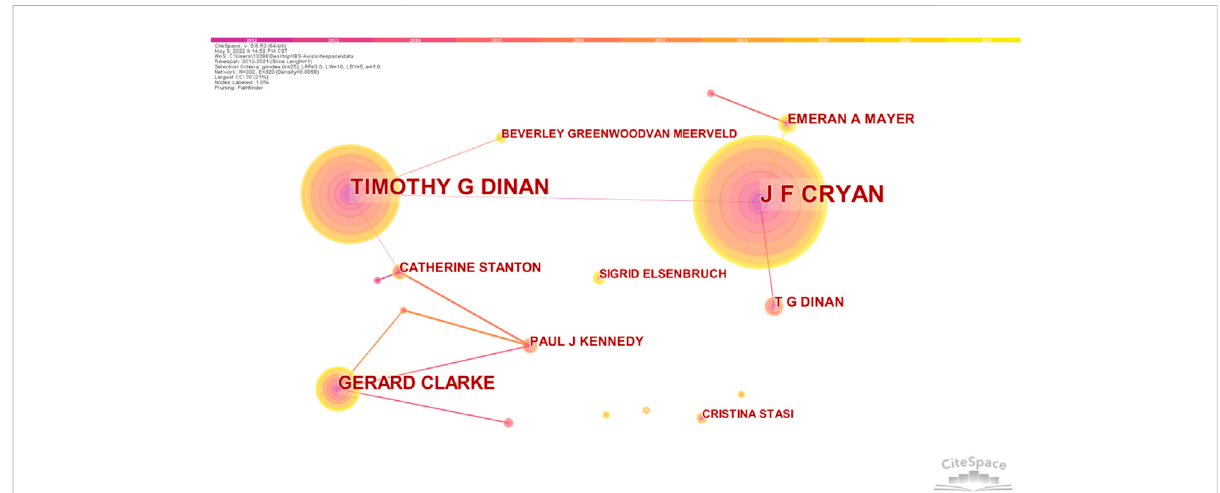
FIGURE 5 Author ’ s collaboration network of research on IBS and the brain – gut axis.